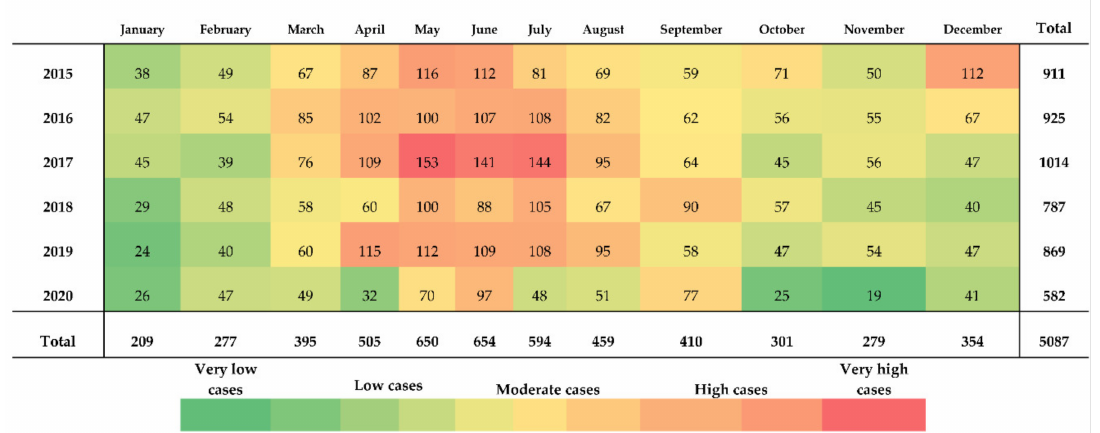
Figure 10. Reported cases of human brucellosis in Kyrgyzstan from 2015 to 2020 by per month. Numbers in bold give the sum of case numbers per year or month. Adapted based on data from the